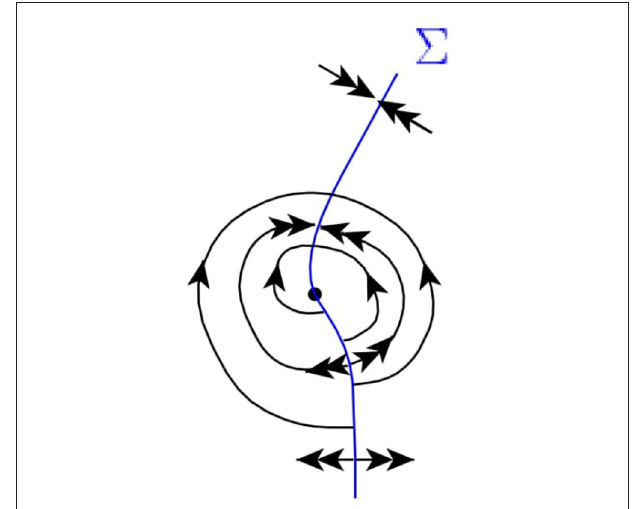
FIGURE 7 | Dynamics around a simple singular equilibrium: the case of a folded focus.